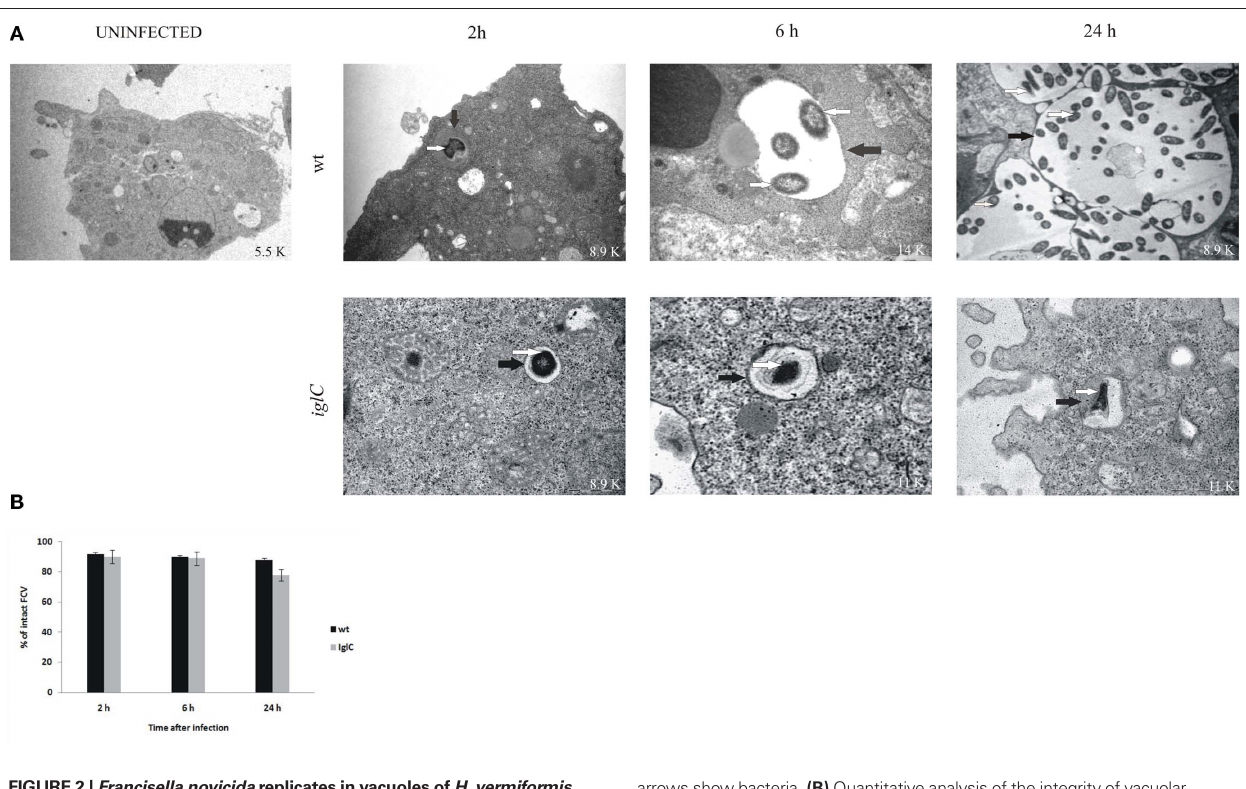
arrows show bacteria. (B) Quantitative analysis of the integrity of vacuolar membranes containing wt F. novicida or iglC in H. vermiformis cells. The percentage of disrupted vacuoles harboring bacteria at different